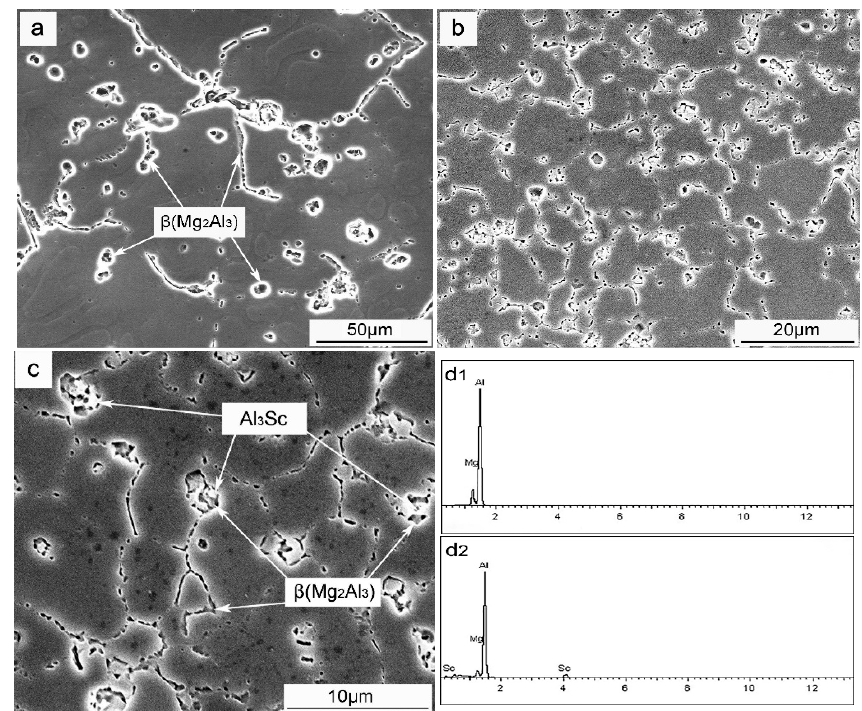
Figure 5. SEM images of ( a ) Al-Mg alloy deposits and ( b , c ) Al-Mg-0.3Sc alloy deposits. ( d1 ) Energy dispersive spectrometry (EDS) spectra of the primary Al 3 Sc phase and ( d2 ) EDS spectra of the Mg 2 Al 3 phase.